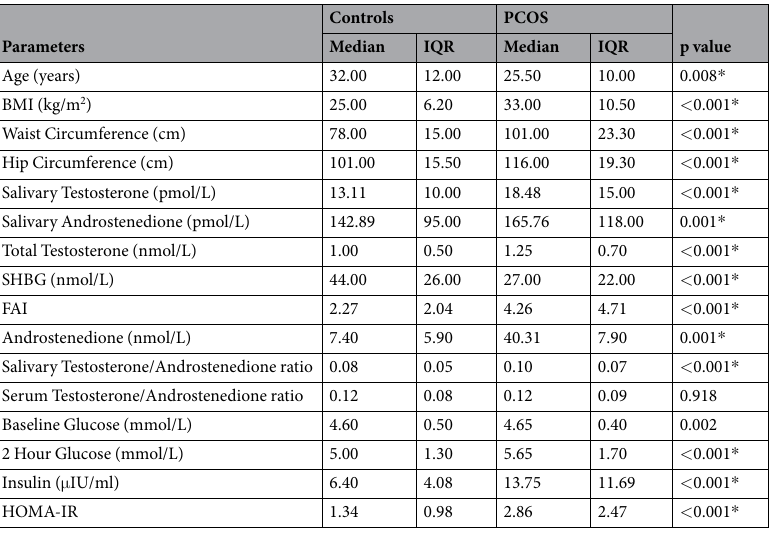
Table 1. Comparison of various anthropometric and hormonal parameters between women with PCOS and controls. BMI – Body Mass Index; FAI – Free Androgen Index; HOMA-IR – Homeostasis model of assessment – insulin resistance: IQR – inter quartile range. To convert values for glucose to milligrams per deciliter, divide by 0.056. To convert values for insulin to picomoles per liter, multiply by 6. To convert values for testosterone to nanograms per deciliter, divide by 0.03467. To convert values for SHBG to micrograms per deciliter, divide by 34.7 . Demographics of the 175 subjects involved in the study, 65 women without PCOS and 110 women with PCOS. The diagnosis of PCOS was based on all three diagnostic criteria of the Rotterdam consensus, namely clinical and/or biochemical evidence of hyperandrogenemia (Ferriman-Gallwey score > 8; free androgen index > 4 respectively), oligomenorrhea or amenorrhea and polycystic ovaries on transvaginal ultrasound. These women therefore represented the phenotype with the greatest metabolic